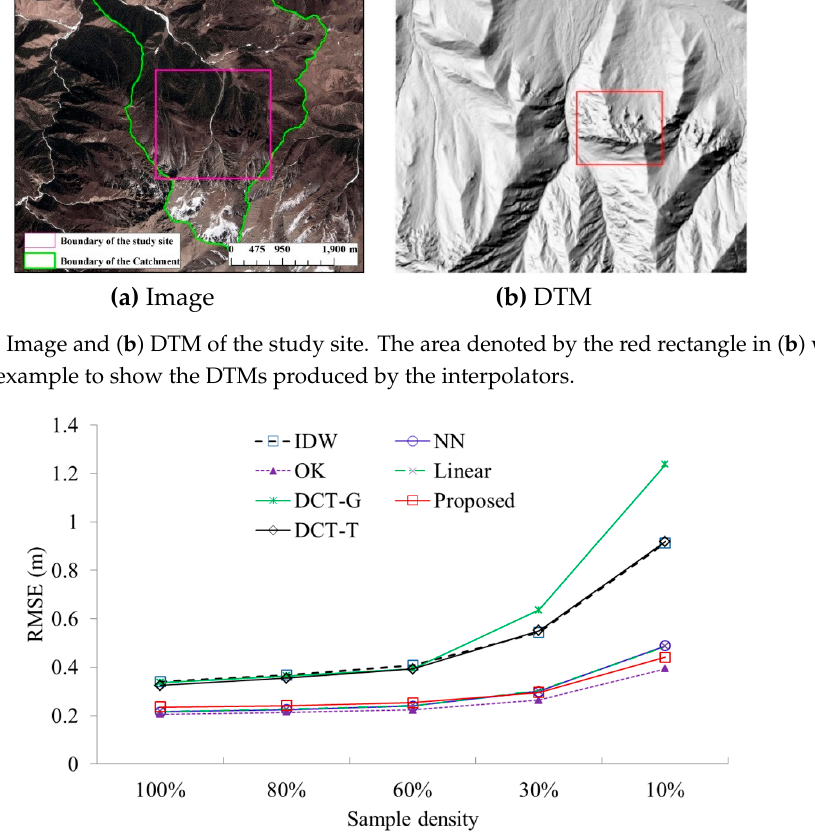
Figure 9. ( a ) Image and ( b ) DTM of the study site. The area denoted by the red rectangle in ( b ) will be taken as an example to show the DTMs produced by the interpolators.